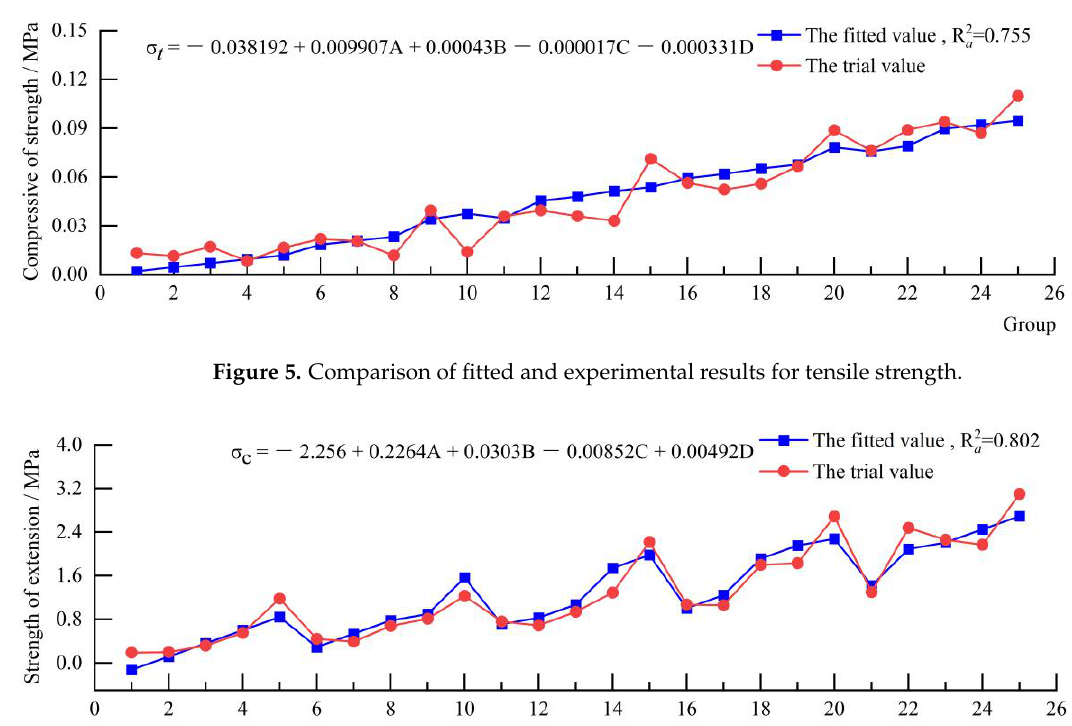
Figure 4. Comparison of fitted and experimental results for density.